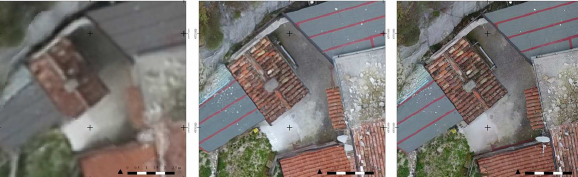
Figure 12. Comparison for a zoomed excerpt: eBee, average GSD=5 cm/px (left); DJI Phantom, average GSD=2,18 cm/px (centre); fusion model, average GSD=0.92 cm/px (right)